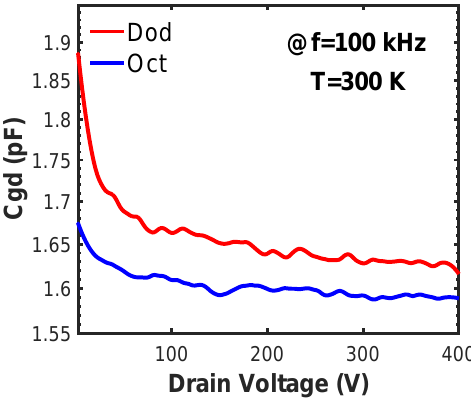
Figure 3. The C gd of 650 V SiC MOSFETs with the Dod and the Oct cells.